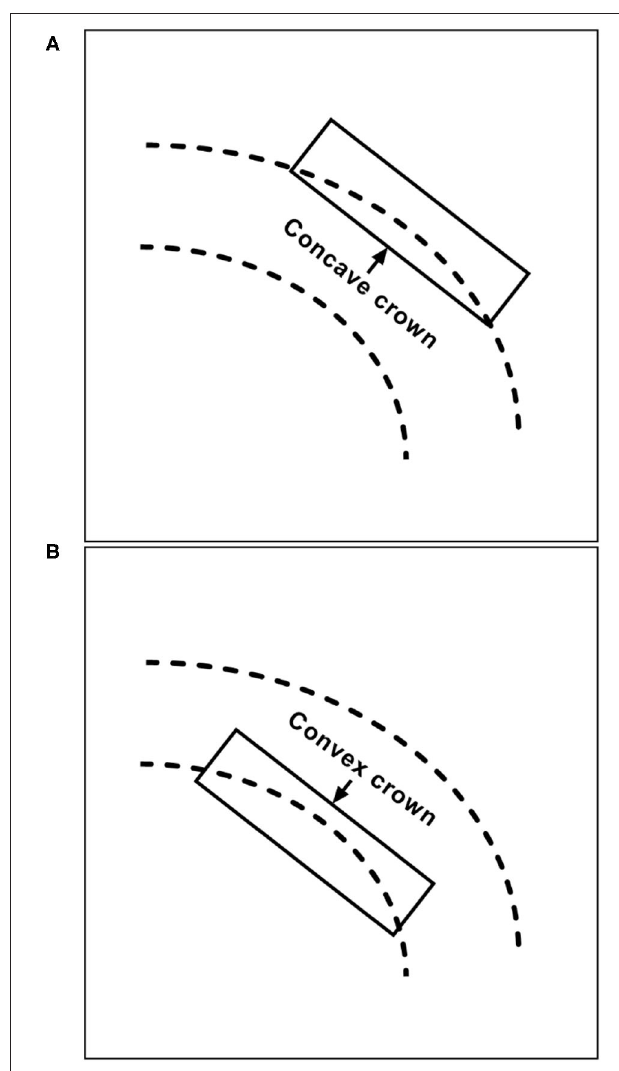
FIGURE 3 | Illustration of (B) convex and (A) concave crowns in the structure of the NAS. NAS, Neuroform Atlas